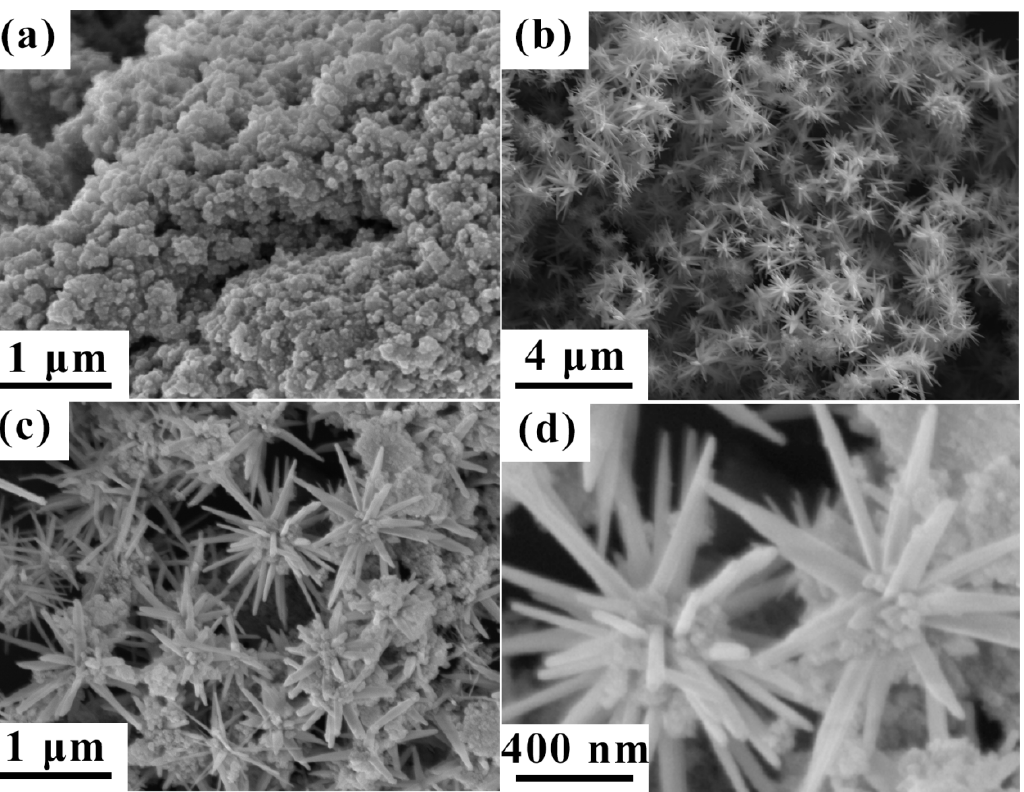
Figure 4. SEM images of Fe 3 O 4 nanoparticles ( a ), Co clusters ( b ), and Co/Fe 3 O 4 composite particles ( c , d ).